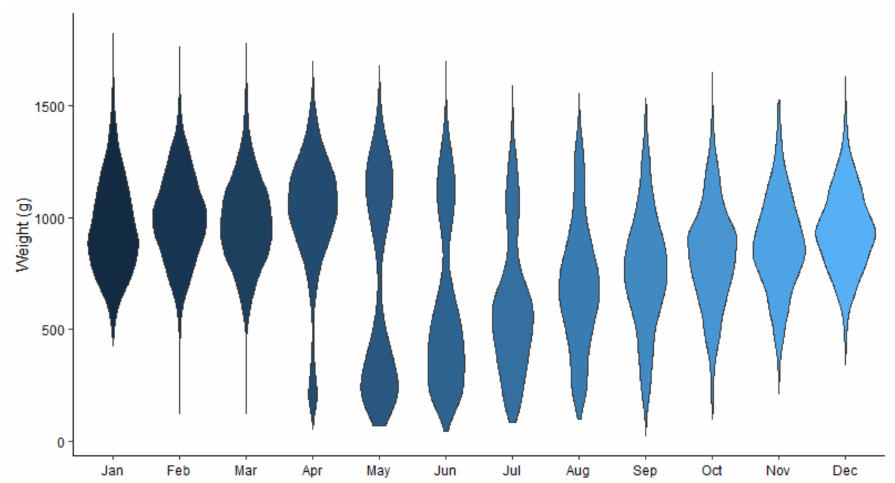
Figure 7. Distribution of the body weight of the dissected muskrats per